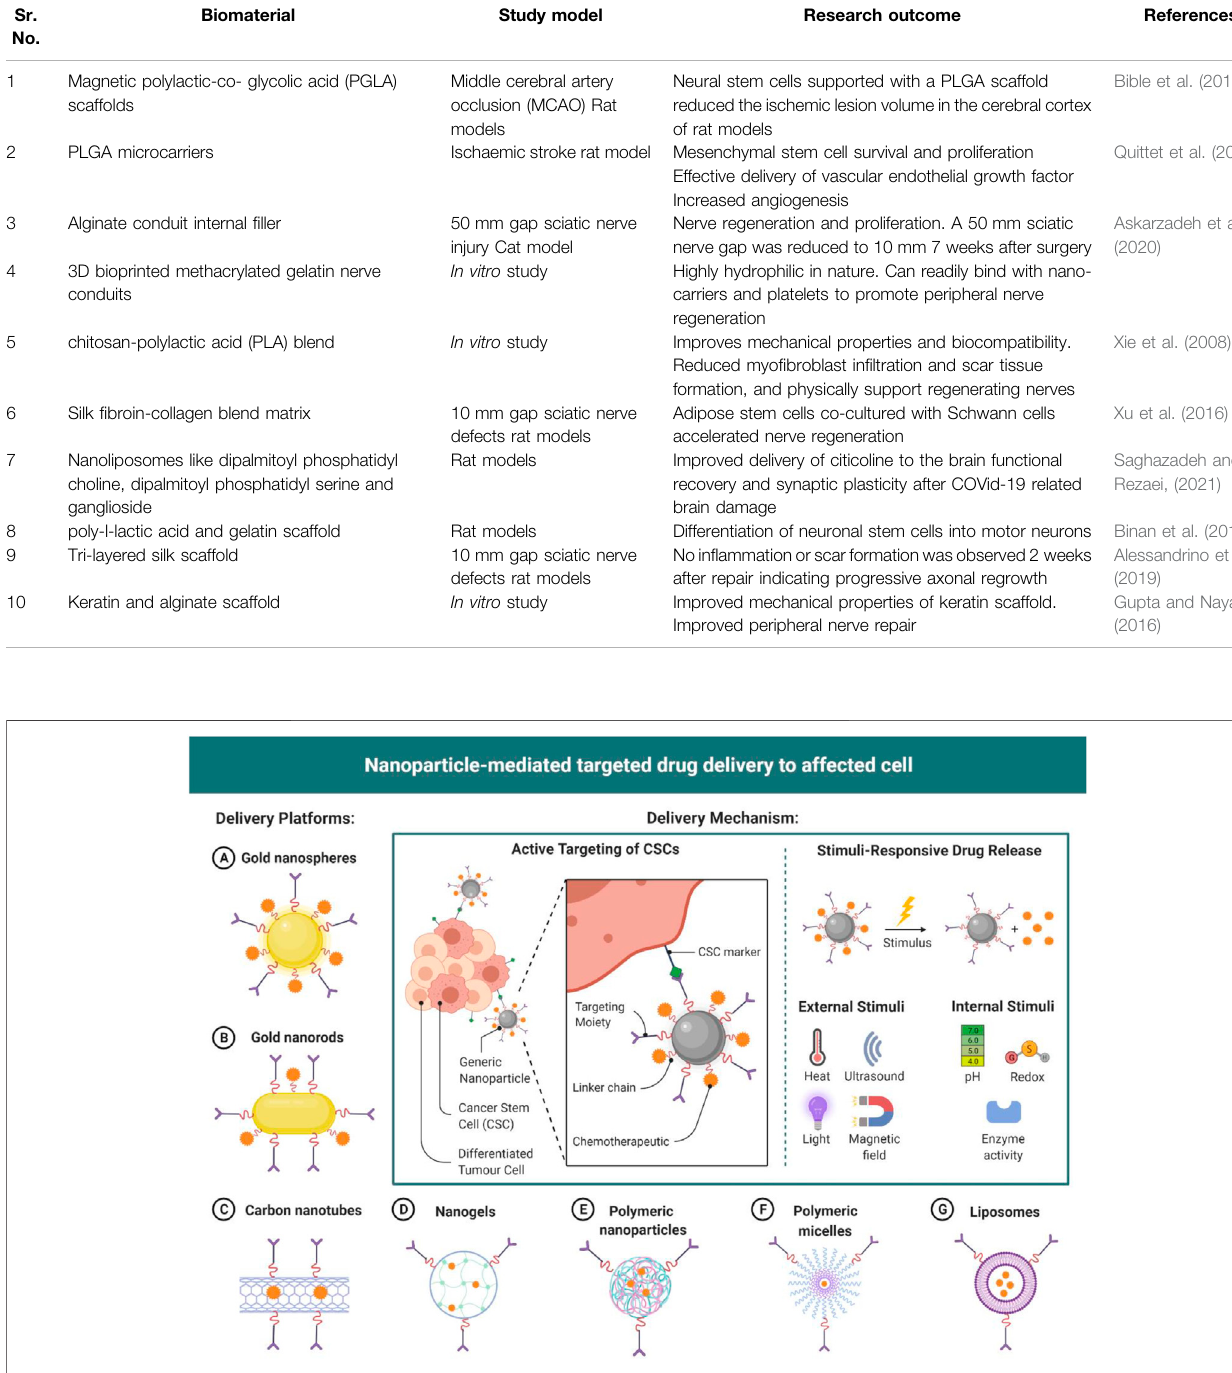
Frontiers in Bioengineering and Biotechnology |